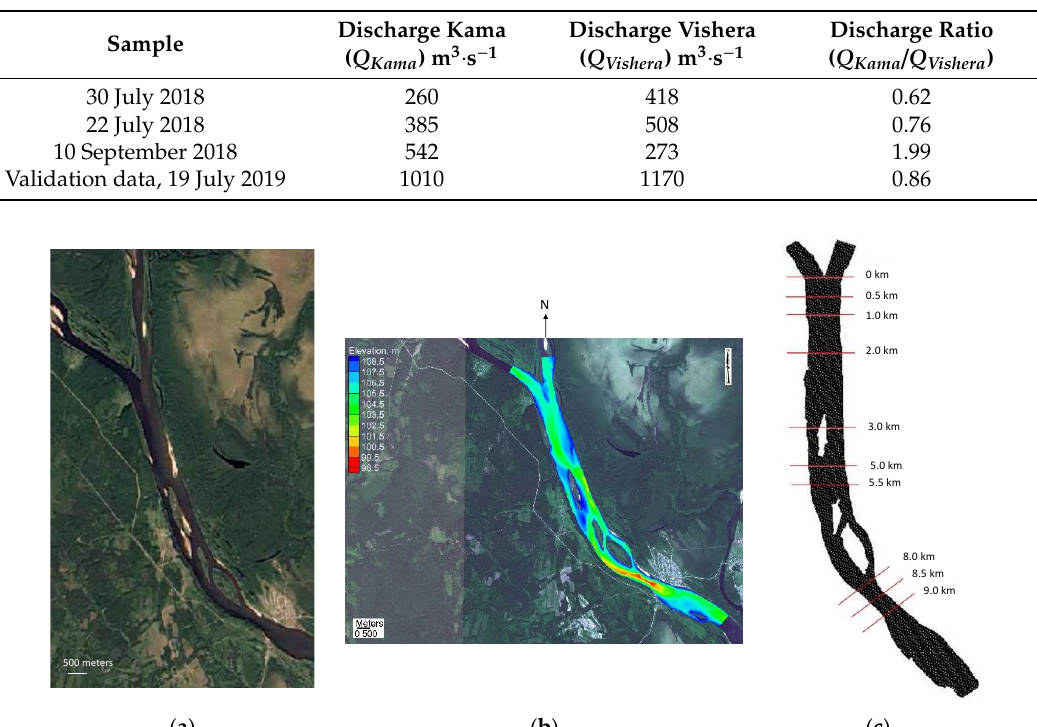
Table 1. Discharge ratios sampled in this study.